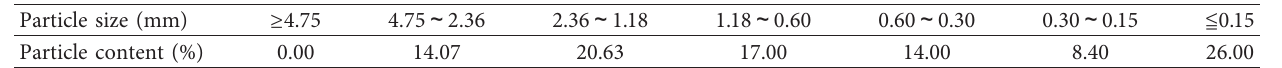
Table 3: Size distribution of loess screening result.